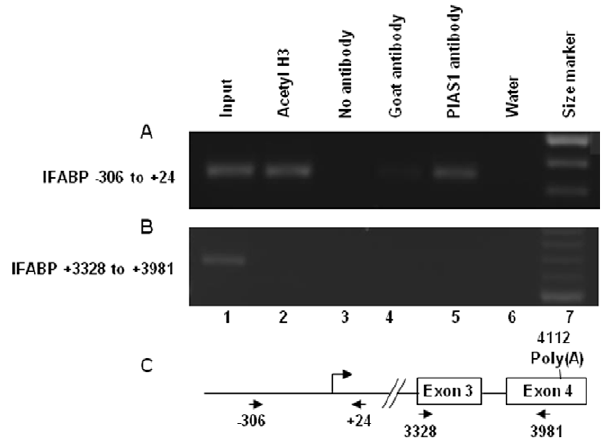
Figure 3. PIAS1 binds to IFABP promoter in isolated murine villus epithelial cells. Cross-linked chromatin isolated from murine villus epithelial cells were sheared and immunoprecipitated with acetylated histone H3 antibody (lane 2), no antibody (lane 3), nonimmune goat antibody (lane 4) and PIAS1 antibody (lane 5). The chromatin immunoprecipitates were purified, reverse cross-linked and analyzed by semiquantitative PCR with primers corresponding to IFABP promoter ( panel A ) or primers from 3 9 region of the IFABP gene ( panel B ). Lane 1 is input control (5%). Lane 6 is water control for used during the PCR reaction. Size marker was run in lane 7. In panel C , the nucleotide coordinates of the primers with respect to IFABP genomic clone (GenBank accession # M65033) is shown. Cap site, exons and the poly(A) signal are indicated.